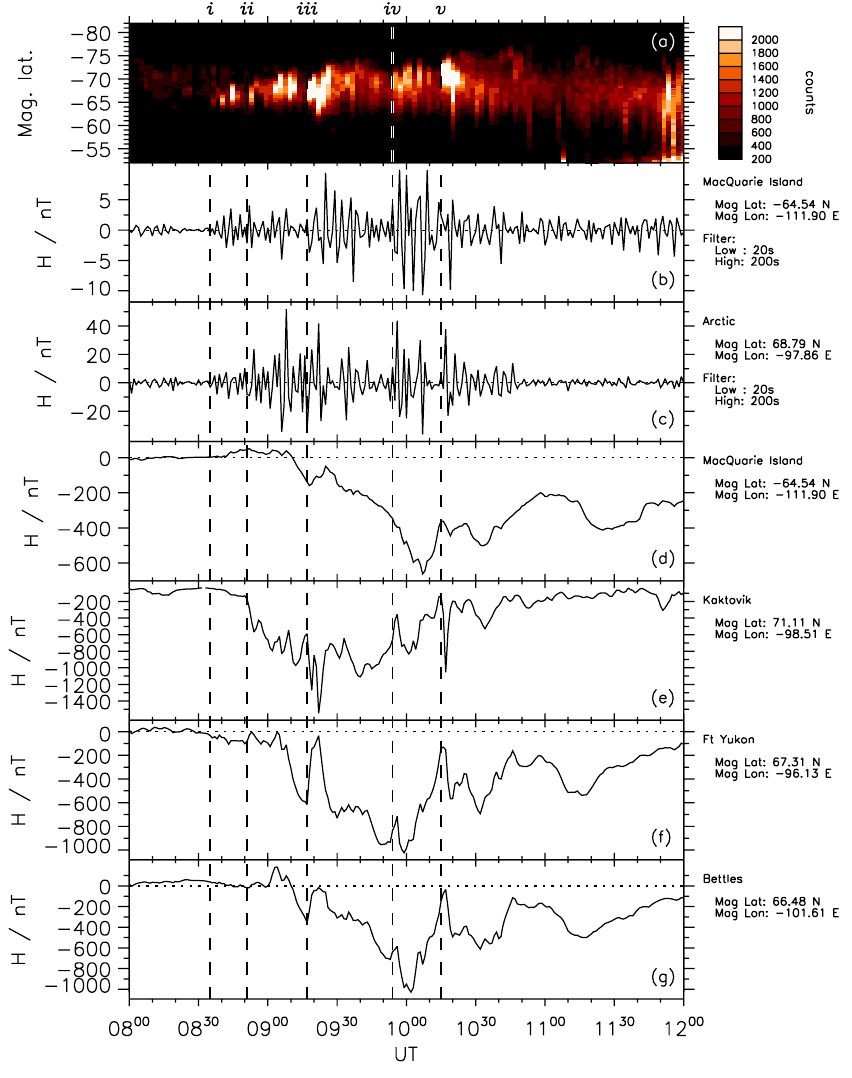
Fig. 2. Auroral and magnetic data, used to identify the time-line of substorm activity over the interval 0800 to 12:00 UT. Panel (a) shows a keogram of the maximum auroral intensity between 18:00 and 04:00 MLT, obtained from the FUV wideband imaging camera on the IMAGE satellite. The bar to the right of this panel indicates the colour-coded relative intensity of the emissions. Panels (b) and (c) show Pi2 filtered (20–200s) H-component magnetometer data from the MacQuarie Island and Arctic stations. Panels (d–g) show the unfiltered H-component data from the MacQuarie Island, Kaktovik, Ft. Yukon, and Bettles stations. The time of the initial disturbance is indicated by the first vertical dashed line at 08:35 UT, with subsequent intensifications also similarly